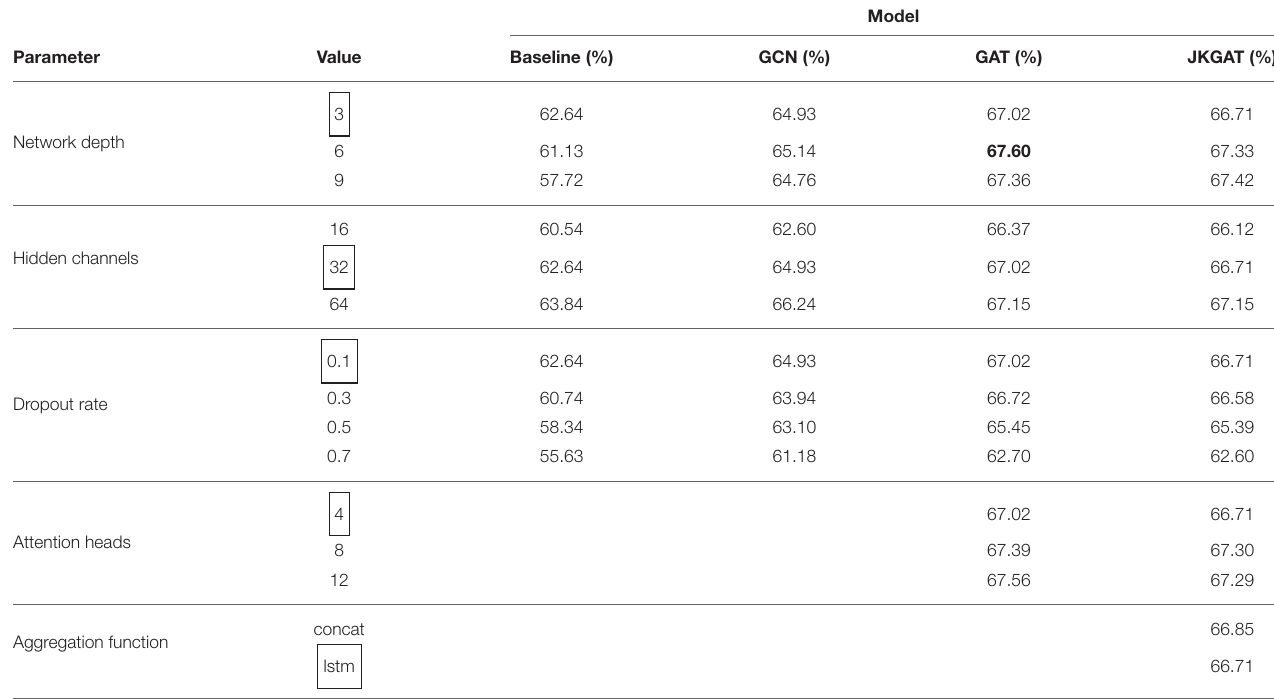
TABLE 1 | Model classification accuracy as a function of network architecture and